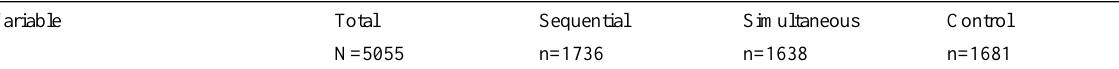
Table 1. Demographics, health status, and lifestyle behavior of the study sample at